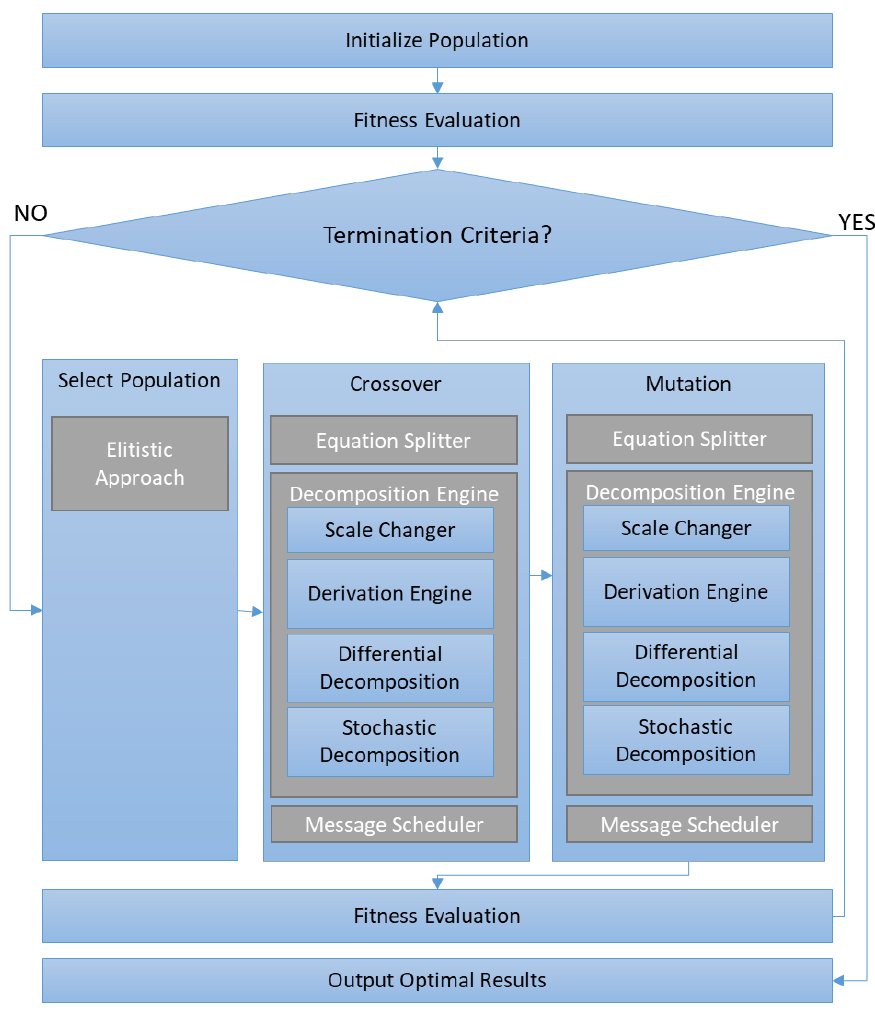
Figure 4. Diagram flow of the Genetic Algorithm.